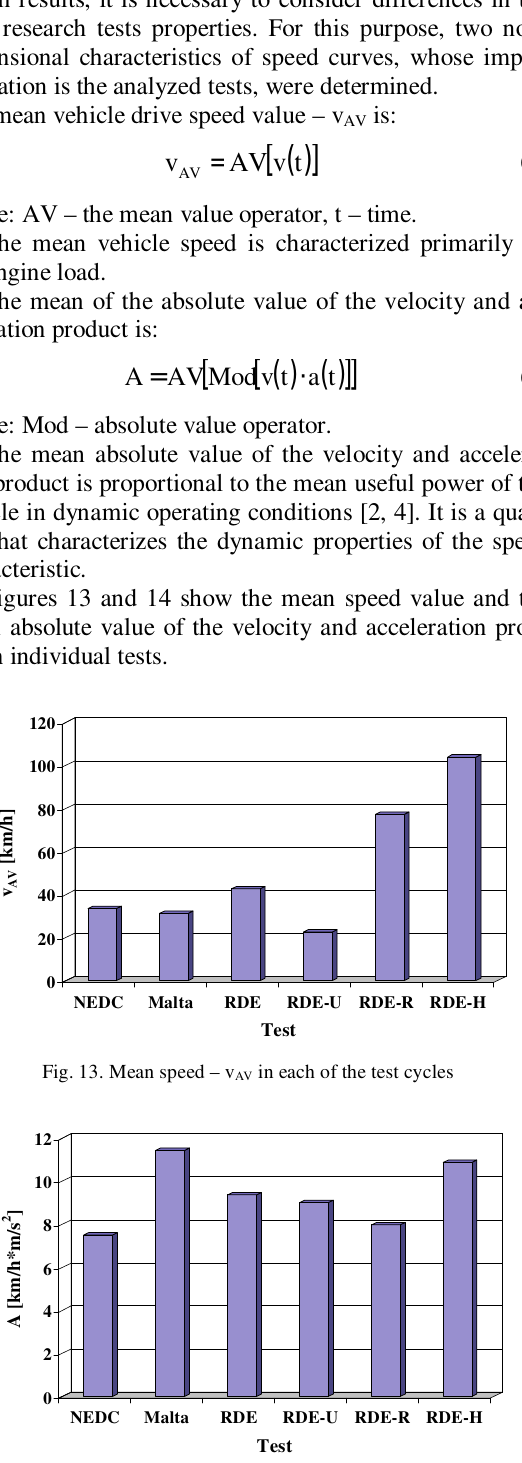
Fig. 14. The mean absolute value of the velocity and acceleration product – A in each of the test